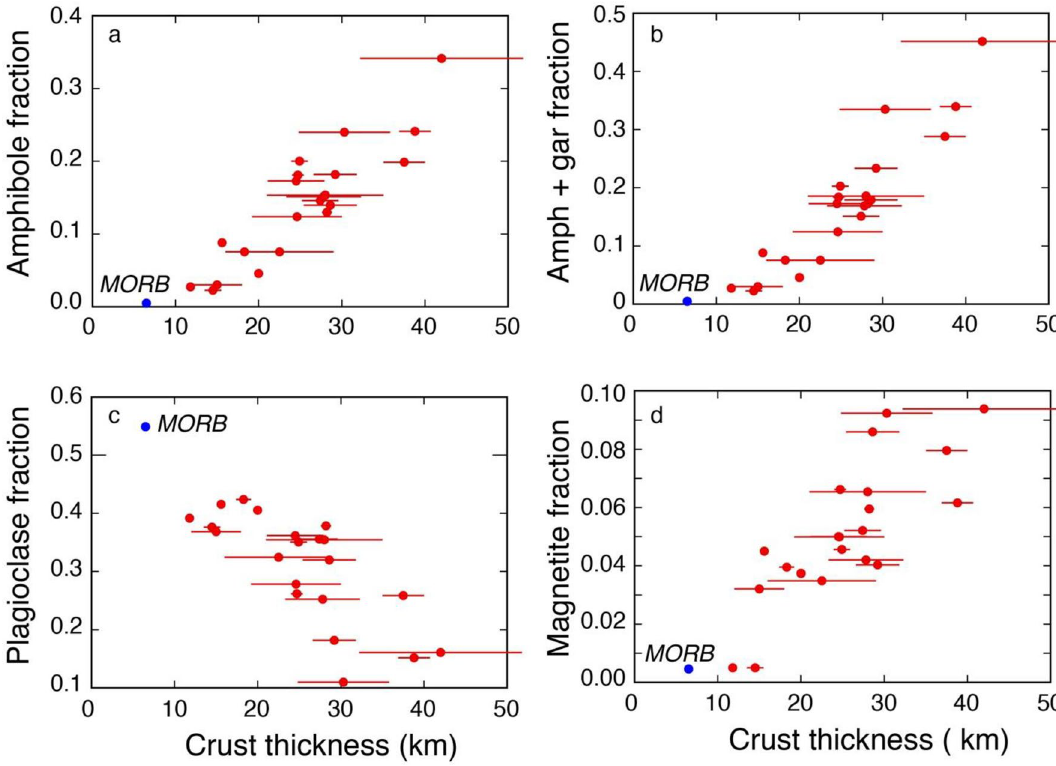
Figure 4. Results of Monte Carlo modelling of fractionating mineral proportions. ( a ) Proportion of amphibole fractionating in arc magmas with respect to arc thickness; ( b ) proportion of amphibole (Amph) + garnet (gar) fractionating in arc magmas with respect to arc thickness; ( c ) proportion of plagioclase fractionating in arc magmas with respect to arc thickness; ( d ) proportion of magnetite fractionating in arc magmas with respect to arc thickness. Data are reported in Supplementary Table